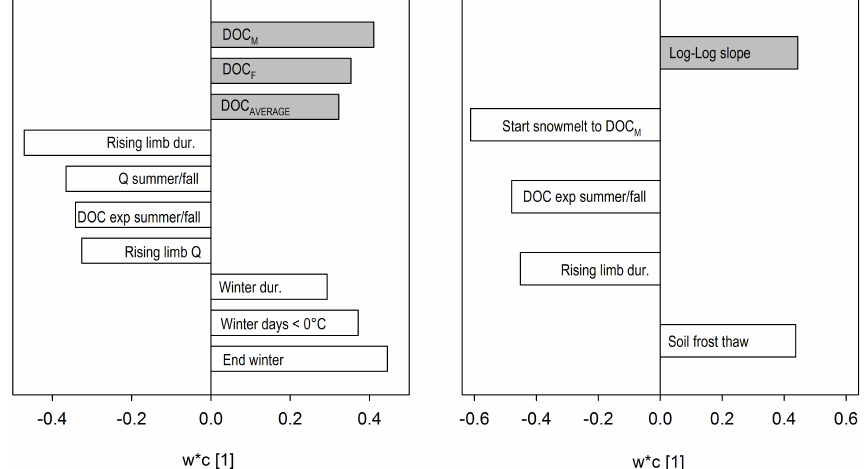
Fig. 5. PLS weight plot, showing that high DOC M , DOC F and DOC AVERAGE correlate positively to long winters and negatively to previous export during summer/fall and low intensity snowmelts with much water ( R 2 X = 0.46, R 2 Y = 0.41, Q 2 = 0.29) (Left panel). PLS weight plot, showing that high Log-Log slope correlates positively to delayed soil frost thaw and negatively to low intensity snowmelts and high previous export ( R 2 X = 0.50, R 2 Y = 0.38, Q 2 = 0.21) (Right panel). Y variables are marked in grey and significant (95% confidence level) X variables in